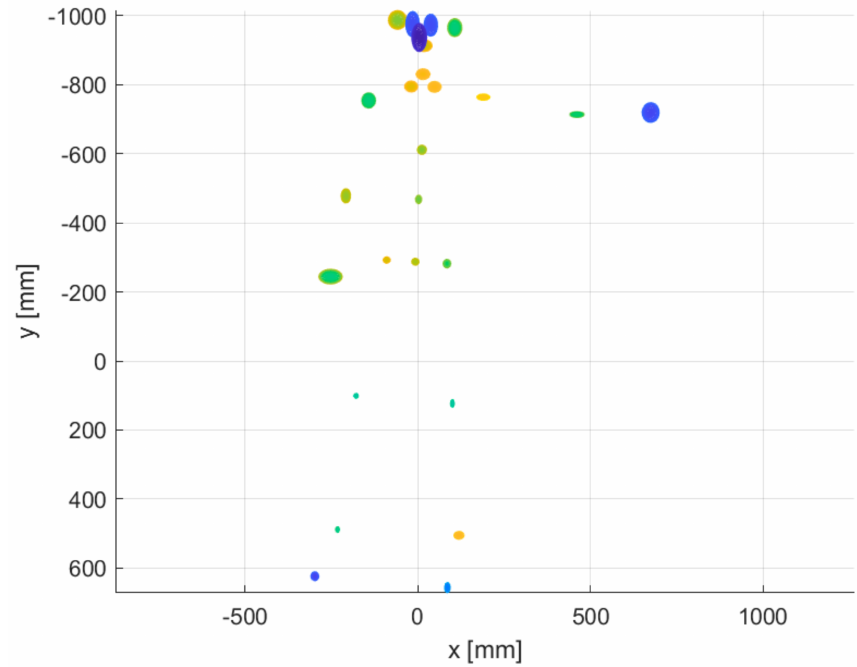
Figure 22. Body joint noise of Azure Kinect in the NFOV